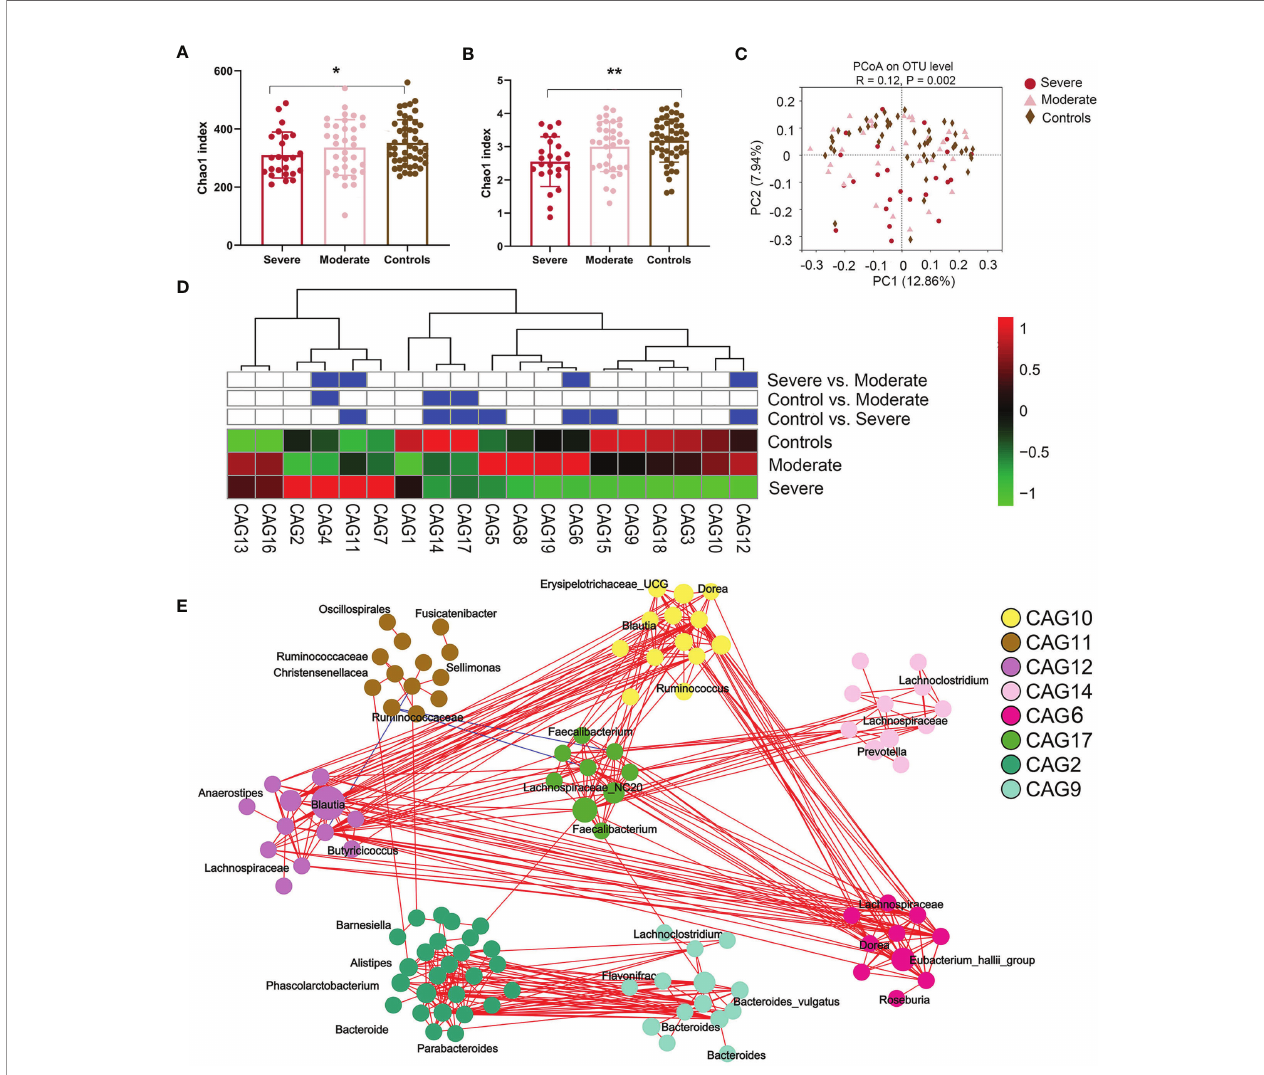
FIGURE 2 | The fecal microbiota from anti- N -methyl- D -aspartate receptor (NMDAR) encephalitis patients with more severe status are distinct from those of healthy controls. (A, B) Comparison of the Chao 1 (A) and Shannon (B) indices between the different disease severity groups and healthy controls. A signi fi cantly decreased intestinal microbiota diversity in NMDAR encephalitis patients with more severe disease status was found. The mean values and standard deviations are presented as bars . * p < 0.05, ** p < 0.01. P- values are from the Kruskal – Wallis test. (C) The overall bacterial signatures between the three groups were markedly different (unweighted Unifrac, PERMANOVA: p = 0.003). (D) Abundances of the 19 co-abundance groups (CAGs) in various NMDAR encephalitis severity subgroups. Abundances were transmuted into Z scores by subtracting the average abundances and dividing the standard deviations for all samples. Z scores were negative (shown in green ) when row abundance was below the mean. CAGs at p < 0.05 (by Wilcoxon rank-sum test) are shown in blue . (E) Operational taxonomic unit (OTU)-level diagram for the enrichment of OTUs in various groups based on the markedly altered CAGs. Node size denotes the mean abundance of each OTU. Bacteria denoted on nodes were of the lowest classi fi cation status that could be identi fi ed by the RDP classi fi er. Lines between nodes denote associations, with line width showing association magnitudes, red denotes positive association, and blue denotes negative associations. Lines corresponding to associations with magnitudes >0.4 were